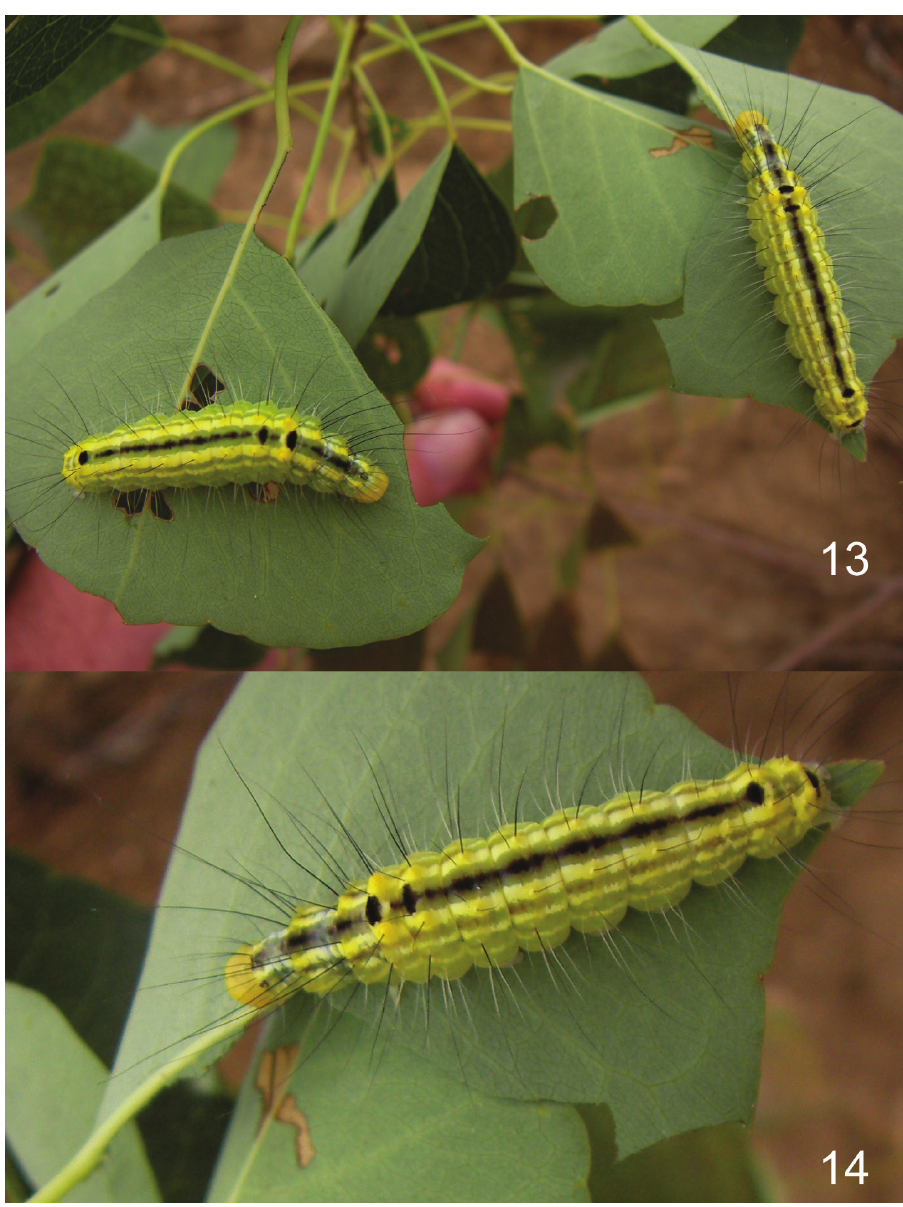
prothoracic shield, pale, less than half length of other setae; single prespiracular seta; SV1 and SV2 on same pinnacula; ventral projection present. T2 and T3 with D1, D2, SD1, and SD2 elongate, black on separate, conical pinnacula; L1 and L2 on same pin- nacula, black (L1 pale on T3), L2 longest, L3 short, pale, and hairlike; SV1 and